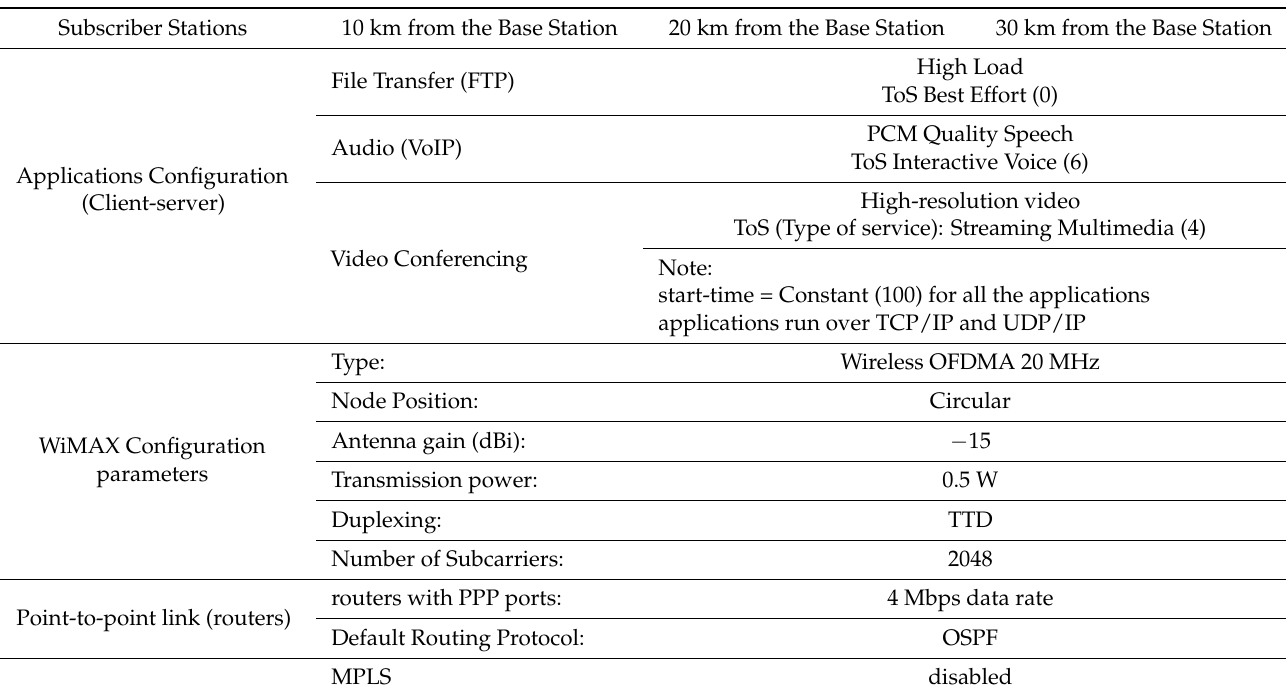
Figure 1. Applications attributes. Table 2. Summary of simulation